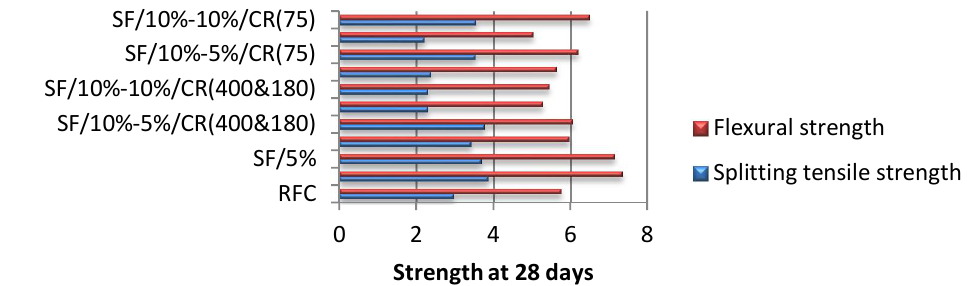
Figure 11. Splitting tensile strength of crumb rubber concrete.